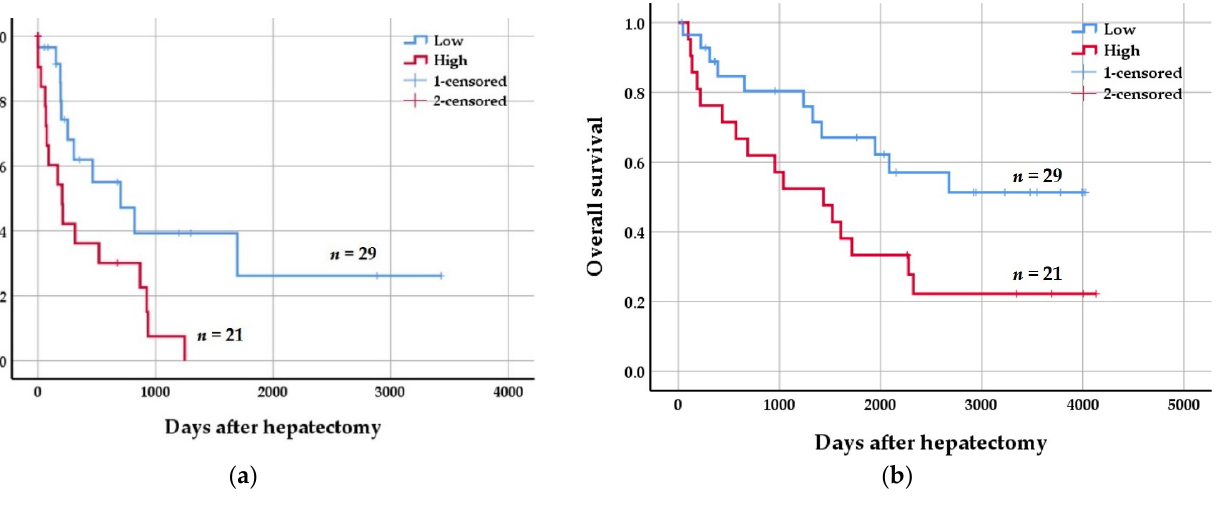
Figure 2. Kaplan–Meier curves of recurrence-free (RFS) and overall (OS) survival rates of hepatocellular carcinoma (HCC) patients according to parafibromin expression status. ( a ) The low parafibromin expression group had better RFS than the high expression group ( p = 0.014, log rank = 6.079). ( b ) The low parafibromin expression group had better OS than the high expression group ( p = 0.036, log rank = 4.414).